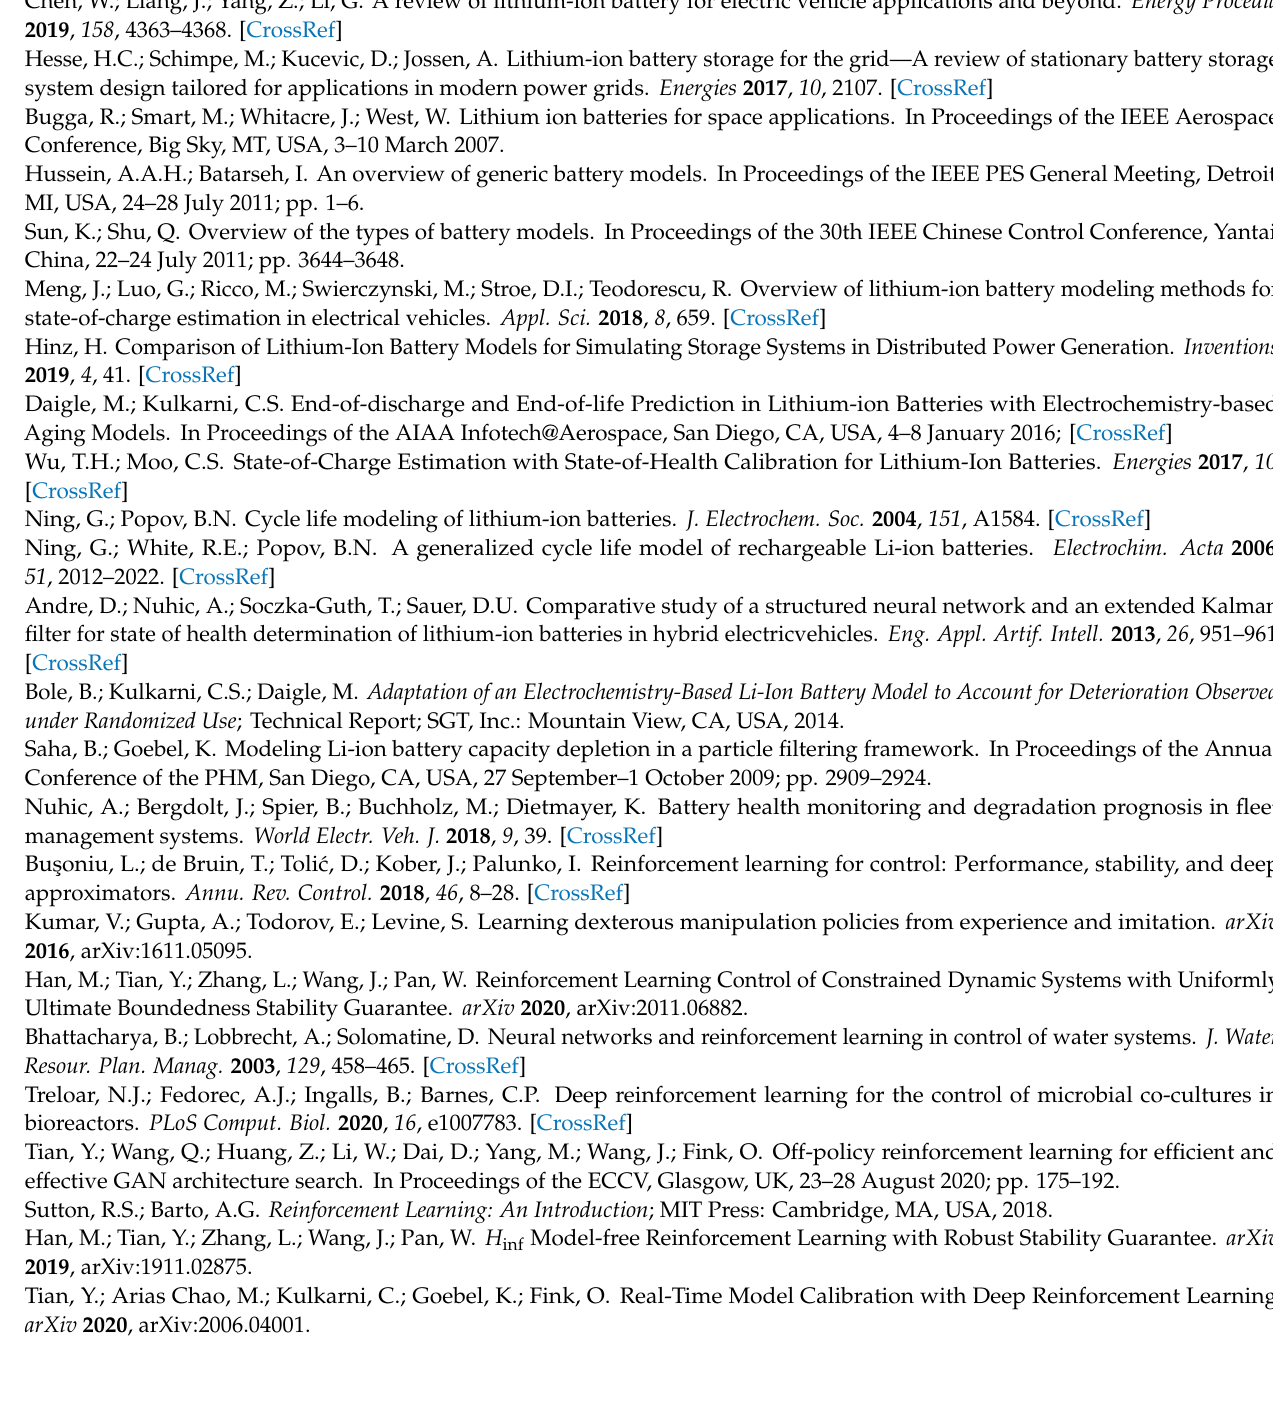
point of the first trajectory in Q max (Figure 2a at t = 0), which corresponds to five different values of R o (Figure 2b at t = 0), and each of the ( Q max , R o ) pairs is a single discharge cycle. Here as well, each trajectory of Q max represents a different load